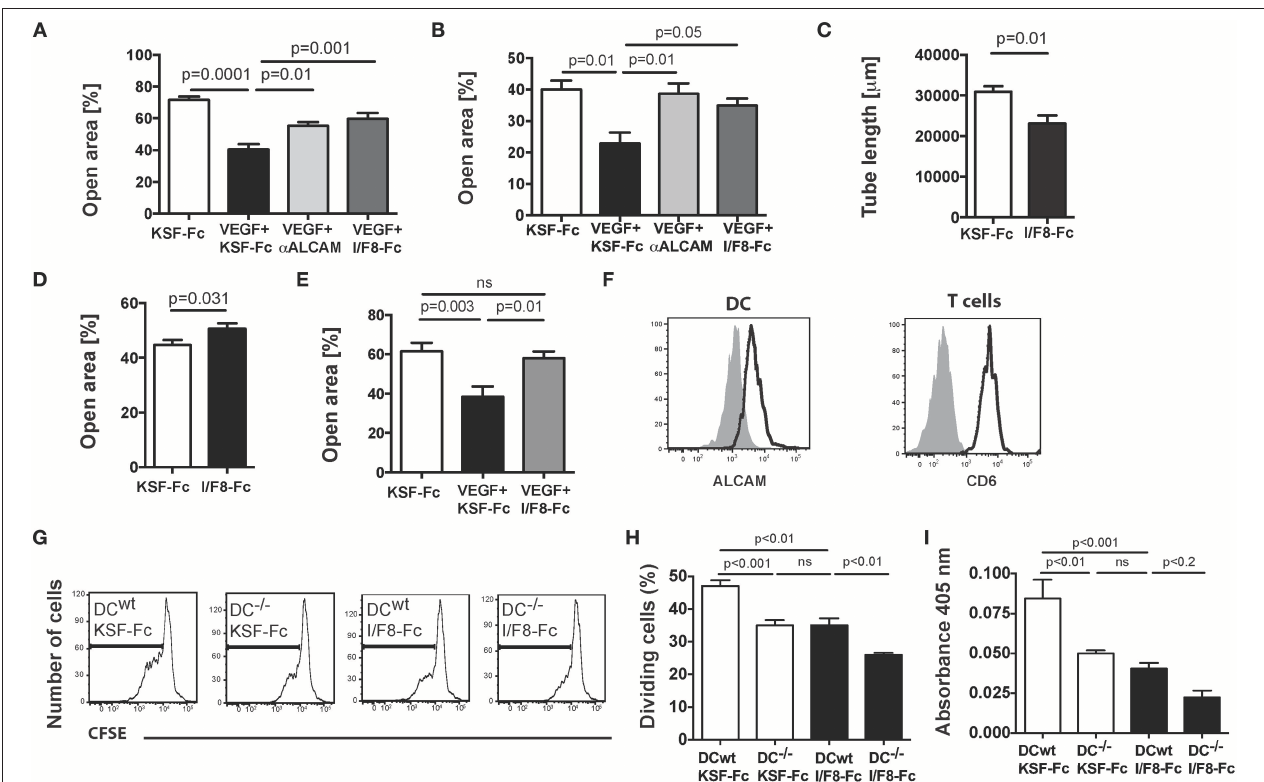
FIGURE 2 | I/F8-Fc reduces (lymph)angiogenic processes and T cell activation in vitro. (A–E) Effects on in vitro (lymph)angiogenis. (A,B) A cell-free scratch was introduced into confluent monolayers of (A) human LECs or (B) HUVECs and the impact of I/F8-Fc or KSF-Fc control antibody on VEGF-A-induced scratch closure was analyzed after 24 and 12h, respectively (C) Blocking ALCAM with I/F8-Fc reduced tube formation of human LECs. (D,E) A cell-free scratch was introduced into confluent monolayers of (D) murine MS-1 cell or (E) murine primary dermal LECs and the impact of I/F8-Fc on scratch closure was analyzed after 24 and 27h, respectively. Data from 1 out of 3 to 4 similar experiments are shown in (A–E) . (F–I) Effects on in vitro T cell activation. WT or ALCAM − / − BM-DCs were pulsed with OVA peptide in presence of LPS and co-incubated with CD4 + OTII cells in presence of I/F8-Fc or KSF-Fc control antibody. (F) FACS analysis demonstrating ALCAM and CD6 expression in BM-DCs and OTII cells, respectively. (G,H) Impact of I/F8-Fc treatment on T cell proliferation. (G) Representative FACS plots showing CFSE-dilution, as a readout of T cell proliferation. (H) Quantitation of proliferating cells. (I) T cell-mediated IFN- γ production was quantified in the cell culture supernatants. Data from 1 out of 4 similar experiments ( n = 6 replicates) are shown in F-I. KSF-Fc: control antibody. I/F8-Fc: